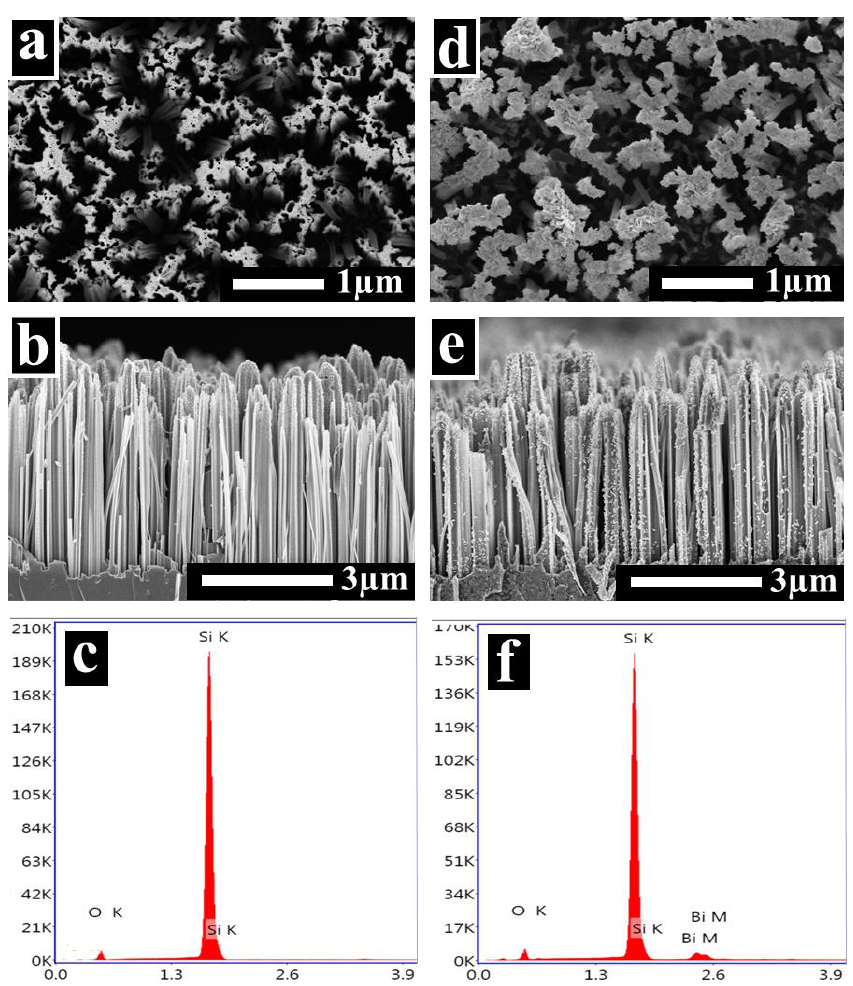
Figure 1. Top-view SEM images of SiNWs: ( a ) before and ( d ) after BiNPs decoration (Bi-3@SiNW sample). ( b , e ) corresponding cross-sectional images and ( c , f ) corresponding EDX spectra.